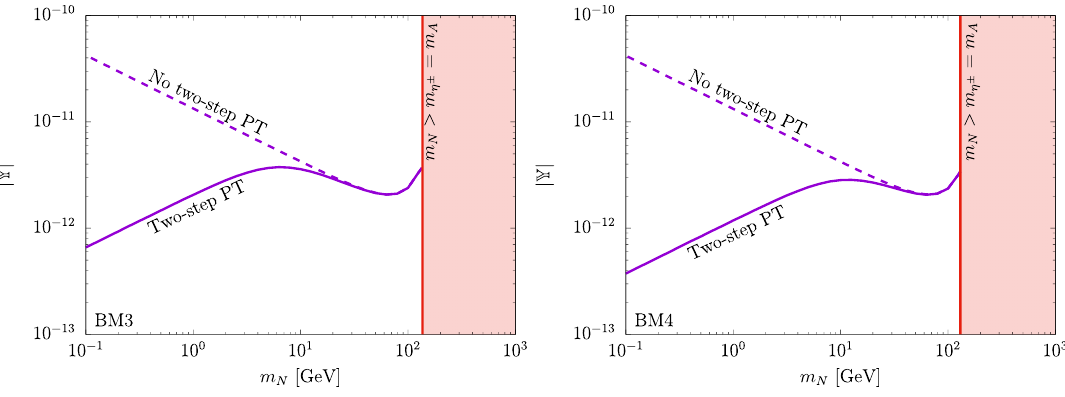
Figure 11 . Contours reproducing the observed relic abundance for BM3 and